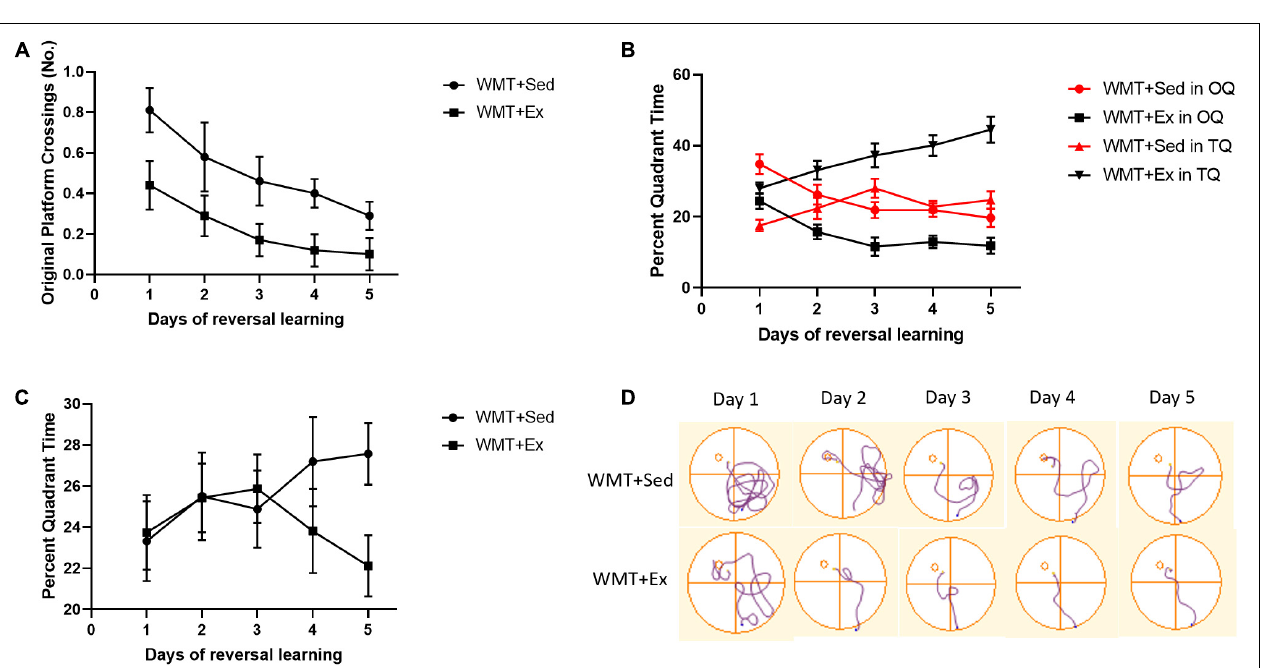
FIGURE 7 | Lower learning efficiency in sedentary mice may be attributable to maintained memory traces. (A) Comparison of the number of crossings over the original platform (the platform during pre-exercise training) between groups of mice that were sedentary with memory traces (WMT + Sed) and mice with memory traces that exercised (WMT + Ex). Mice in the WMT + Sed group show significantly higher numbers of crossings over the original platform location during 5 days of reversal learning than mice in the WMT + Ex group. (B) Comparison of the percentage of time spent in the new target quadrant (TQ) and opposite quadrant (OQ) between the WMT + Sed and WMT + Ex groups during reversal learning. Both groups increase exploration time in the TQ and decrease exploration time in the OQ. However, the difference in exploration time between the TQ and the OQ in the WMT + Sed group is statistically significant only on the first day of reversal learning. By contrast, mice in the WMT + Ex group spend significantly more time in the TQ and less time in the OQ during the last 4 days of reversal learning, but not on the first day. (C) Comparison of the percentage of time spent in the adjacent quadrants (AQs) between the WMT + Sed and WMT + Ex groups during reversal learning. Both groups spent similar time in AQs during 5 days of learning. (D) The trajectories of mice exploring the maze during the 5 days of reversal learning. Data are graphed as means ± SEM ( n = 13) and were analyzed using two-way repeated-measures ANOVAs.